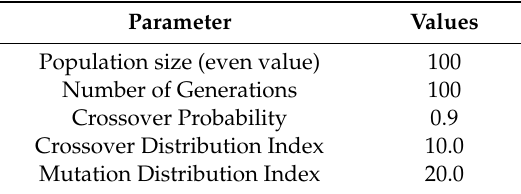
Table 5. The parameters for the optimization